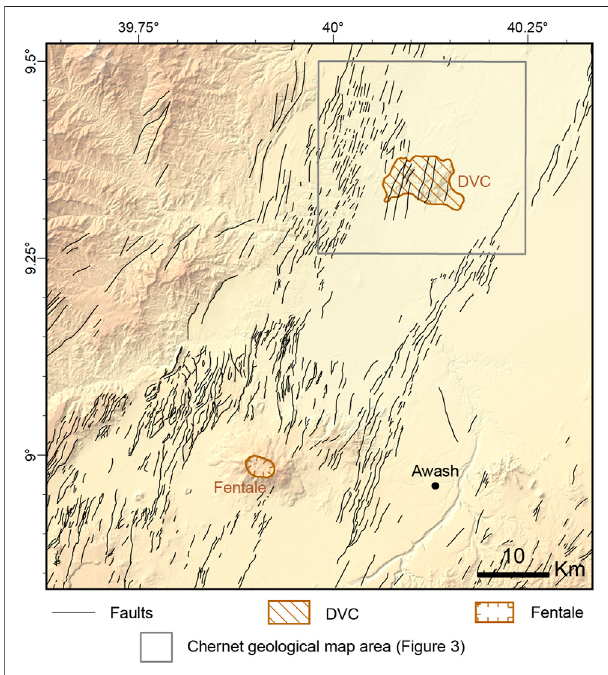
FIGURE 2 | Study area. The solid black lines are the faults. South of 9.2 ° of latitude the faults were derived from the Agostini et al. (2011b) database. North of 9.2 ° they are traced using a combination of the SRTM data in map view and from creation of topographic pro fi les.